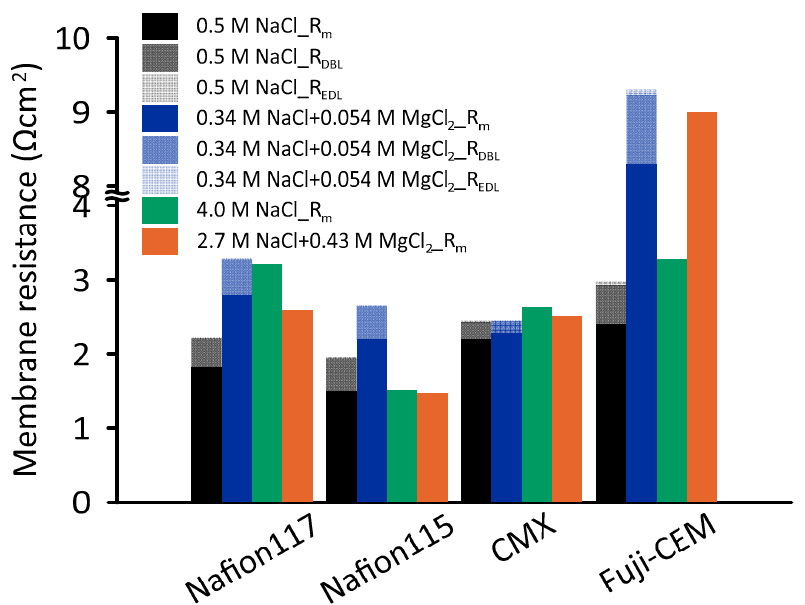
Figure 8. Ionic resistance of Nafion 117, Nafion 115, CMX, Fuji-CEM-80050 in 0.5 M NaCl, 4.0 M NaCl, 0.34 M NaCl + 0.054 M MgCl 2 and 2.7 M NaCl + 0.43 M MgCl 2 at 25 °C.